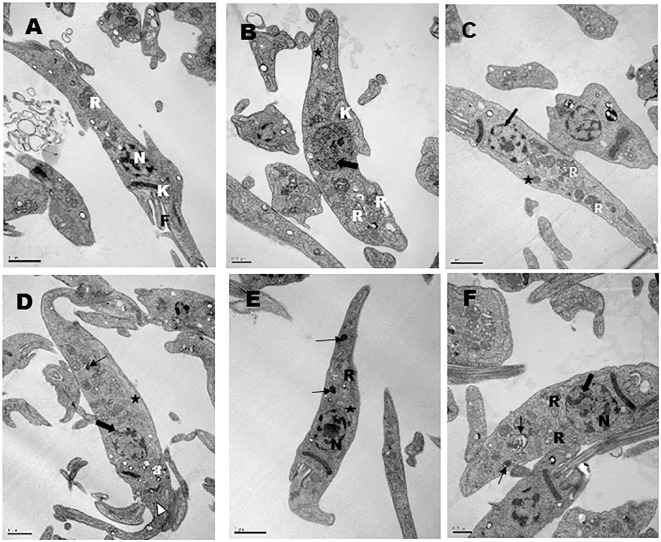
Transmission electron microscopy of Trypanosoma cruzi epimastigotes forms treated for different times with 1μg/ml of temporizin (TZ) or temporizin-1 (TZ1) or Gramicidin (Gra).(A) Untreated parasite, showing the characteristic structure of kinetoplast (K), reservosome (R), flagellum (F) and nucleus (N); (B) Parasites treated for 30 minutes with TZ showing abnormal chromatin condensation (large arrow); mitochondrial cristae disorder (star); kinetoplast disorganization (K) and swelled reservosome (R); (C) 90 minutes of treatment with TZ1 showed mitochondrial cristae alteration (star); disorganization in the reservosome morphology (R); chromatin reduction (large arrow); (D) 3 hours of TZ1 treatment showing chromatin condensation reduction (large arrow); reservosome degeneration (thin arrow); concentration of acidocalcisomes in the anterior region (a); microvesicles releasing near Golgi (white arrow head); mitochondrial cristae reduction (star); (E) 90 minutes of Gra treatment showing a reduction of the mitochondrial cristae (star), disorganization of reservosome morphology (R) and reservosome degeneration (thin arrow); (F) 3 hours of Gra treatment showing chromatin alteration (large arrow), degeneration of reservosomes (thin arrow) and alteration in the reservosome morphology (R).